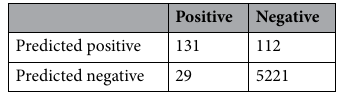
Table 2. Confusion matrix for the cross-validated training group.